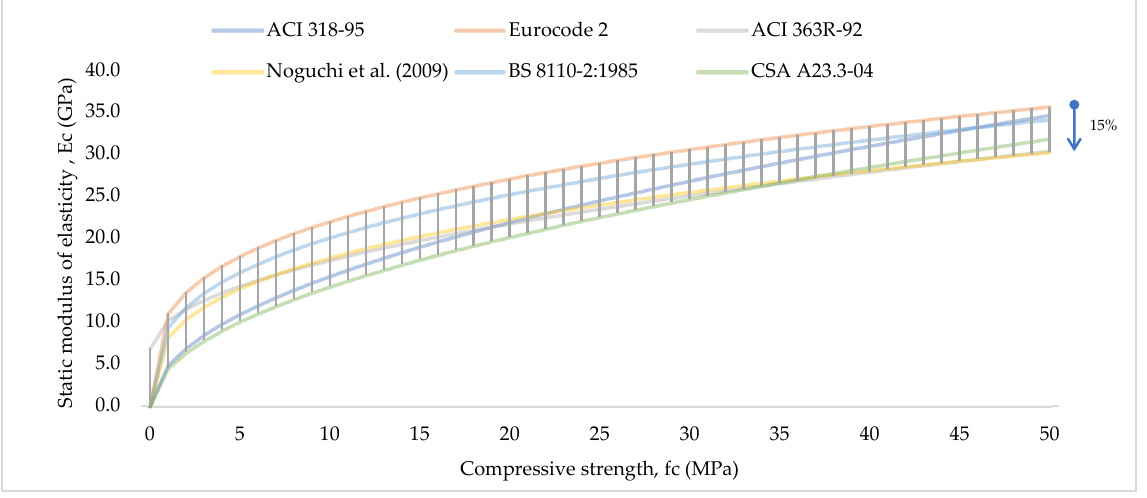
Figure 5. Correlation between Static modulus of elasticity and Compressive strength (Equations (25)–(30)) [49] .